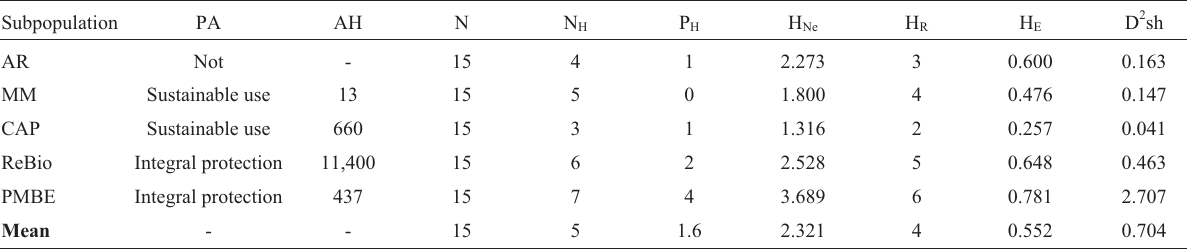
Table 2 - E. ovata subpopulation genetic parameters based on the cpSSR markers. Subpopulation